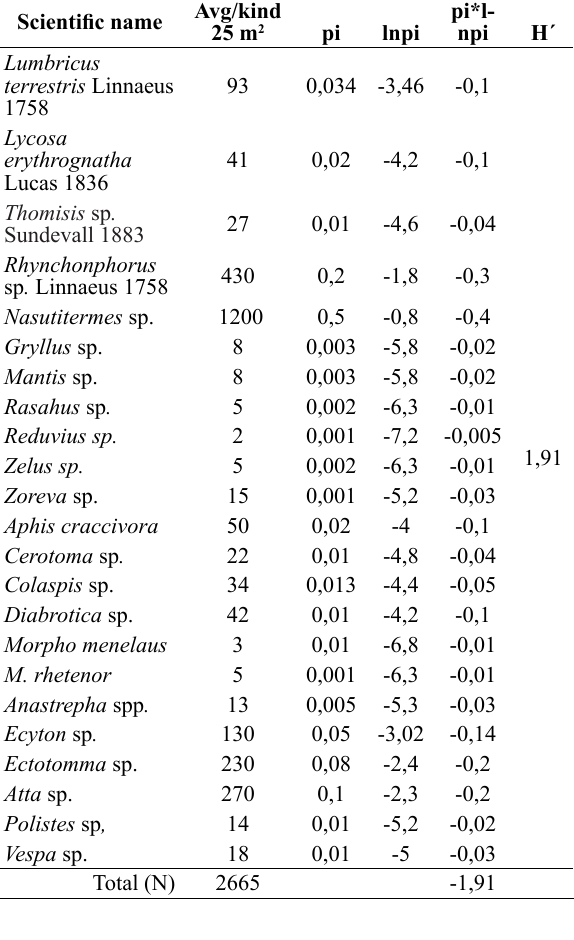
Table 10: Calculation of alpha diversity for arthropods in plots with Amazonian fruit trees on the Iquitos-Nauta highway in Loreto